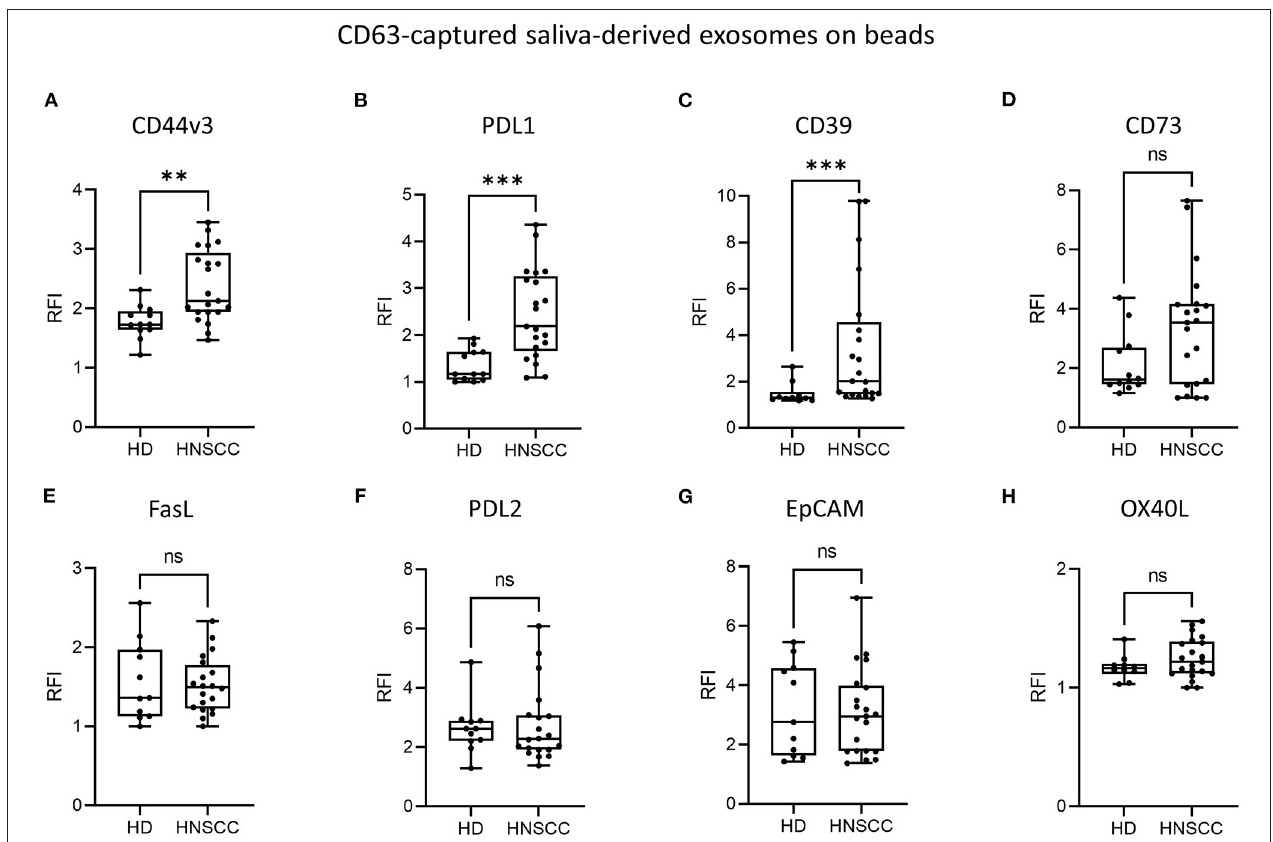
FIGURE 2 | Surface levels of different antigens on saliva-derived, CD63-captured exosomes. Exosomes isolated from saliva of HD ( n = 12) and HNSCC patients ( n = 22) were stained for (A) CD44v3, (B) PDL1, (C) CD39, (D) CD73, (E) FasL, (F) PDL2, (G) EpCAM and (H) OX40L using capture with CD63 antibodies and subsequent bead-based flow cytometry. Surface levels are shown as relative fluorescence intensity (RFI) compared to isotype controls. Saliva-derived exosomes from HNSCC patients showed significantly higher surface values of CD44v3 (A) , PDL1 (B) and CD39 (C) compared to saliva-derived HD exosomes. Results are plotted as box-and-whisker blots representing the median value, the 25 th and 75 th quartiles and the range. P -values were determined by Mann-Whitney test, ** p ≤ 0.01, *** p ≤ 0.001, ns, not